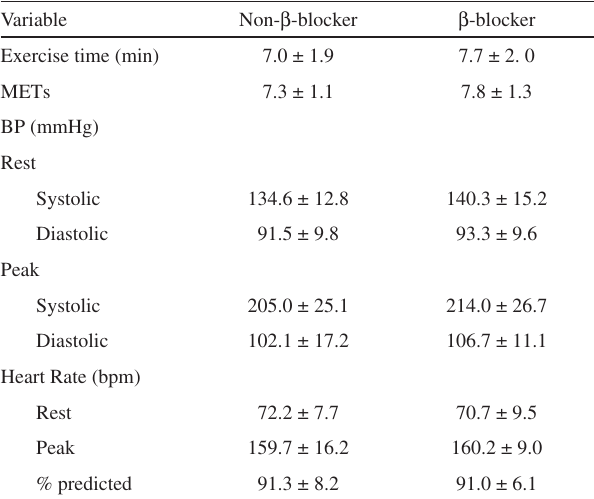
Table 2 - Maximal exercise